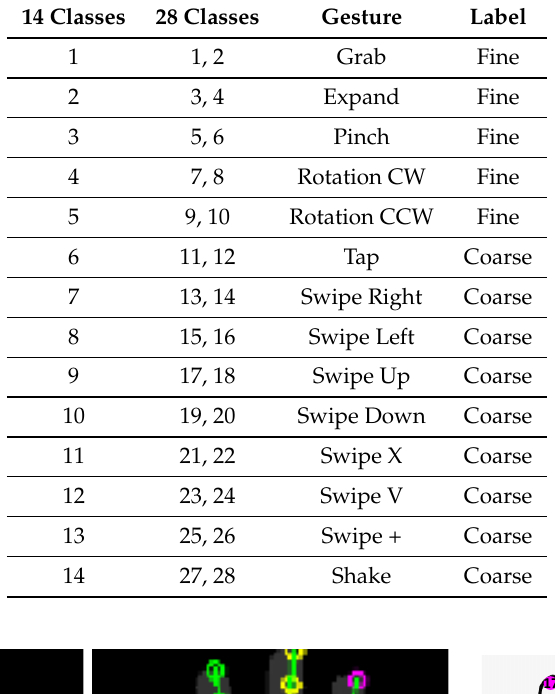
Table 2. List of gestures in the Dynamic Hand Gesture (DHG) dataset.